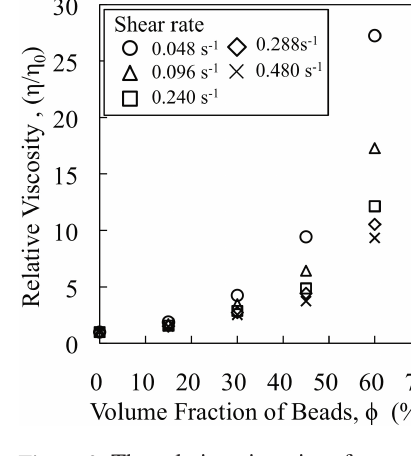
Figure 2. The relative viscosity of suspension as a function of volume fraction (mean diameter of beads: 162.5 µm, viscosity of silicone oil: 0.5 Pa s).